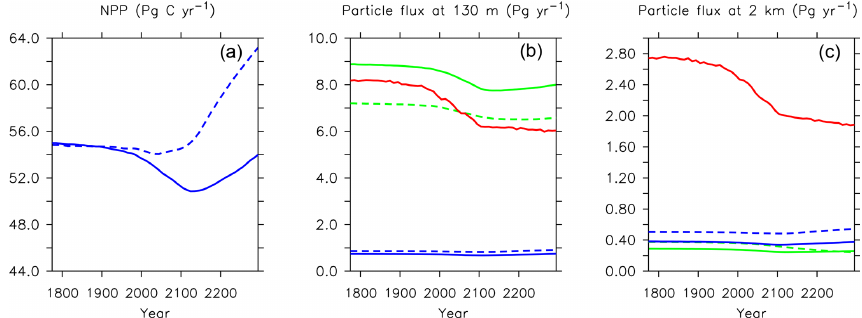
Figure 21. Major biogeochemical fluxes in the model, 1776 to 2300. Panel (a) is total net primary production, (b) is total particle fluxes at 130m depth, (c) is total particle fluxes at 2km depth. Blue lines in the middle and right panels are PIC, green lines are POC, and red lines are opal. Solid lines are from this model (KMBM3); dashed lines are from the Keller et al. (2012) version (KMBM1).